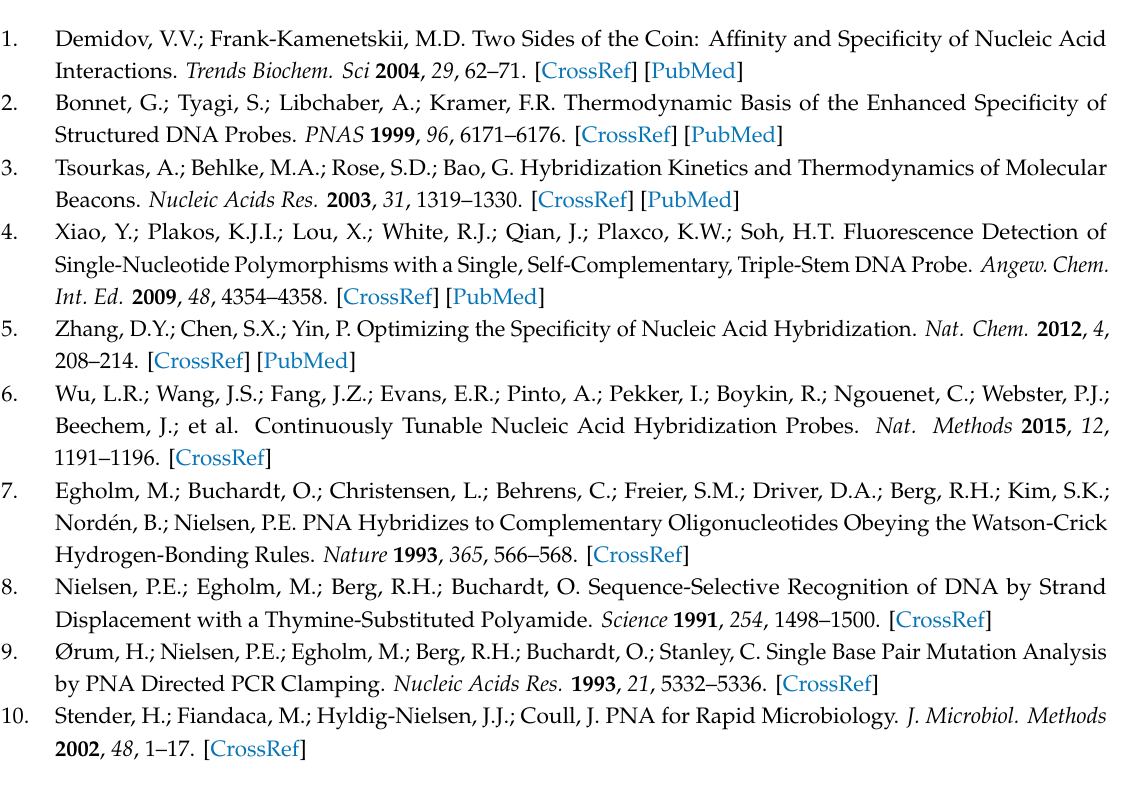
Supplementary Materials: The following are available online. Figure S1: Overlay of SPR sensorgrams for struc_ γ PNA and unstruc_ γ PNA with perfect match DNA target showing greater dissociation of struc_ γ PNA; Figure S2: UV melting curves of unstruc_ γ PNA with perfect match and single mismatch DNA targets; Figure S3: UV melting curves of struc_ γ PNA with perfect match and single mismatch DNA